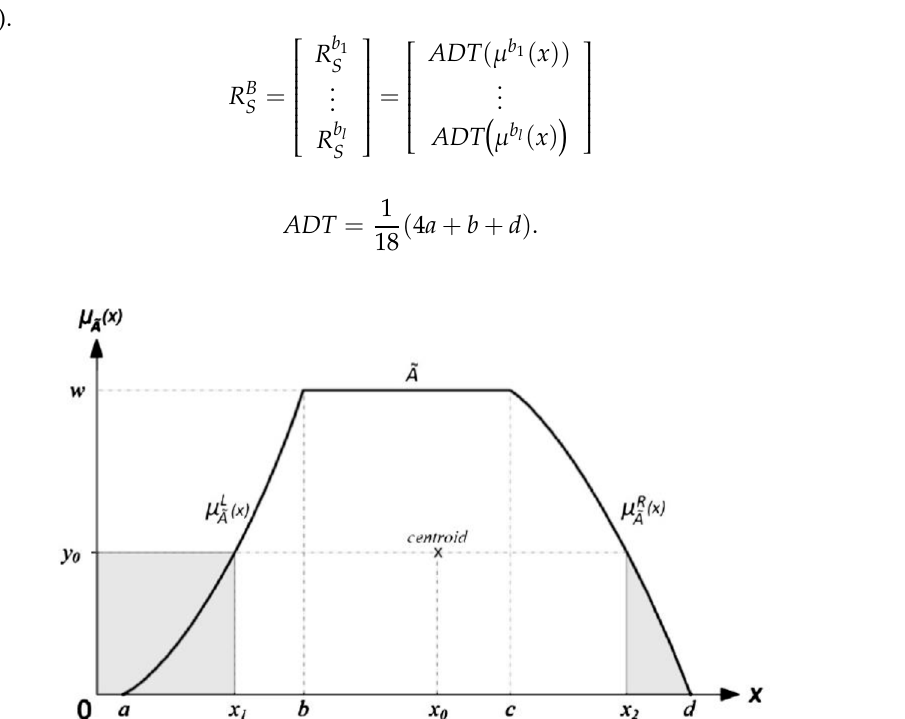
Figure 4. Area defuzzification technique [24].